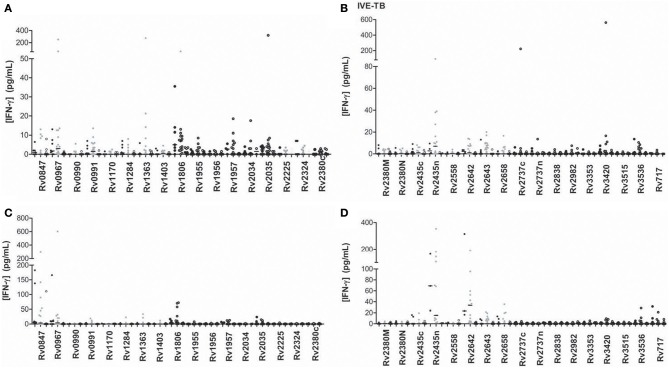
IVE-TB antigen stimulated IFN-γ response (pg/ml) after short (A,B) or long-term (C,D) incubation of whole blood from individuals without LTBI (black dots), with LTBI (gray dots), and active TB patients (empty dots). The horizontal line represents the median.